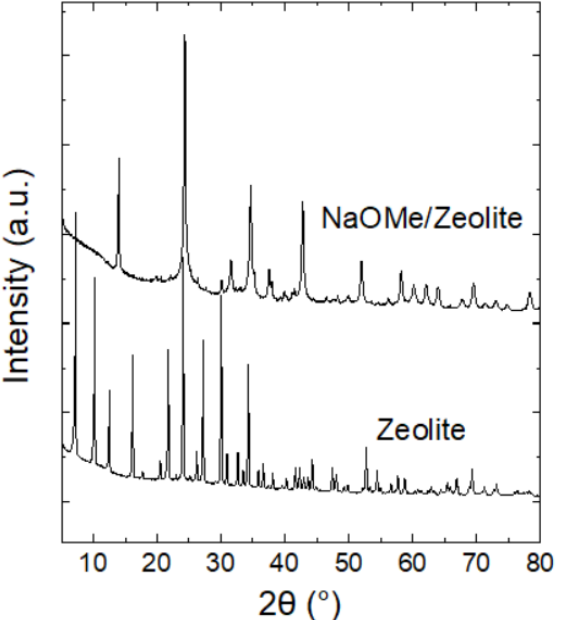
Figure 2. XRD spectrum of ball-milled NaOMe/zeolite catalyst in comparison to zeolite